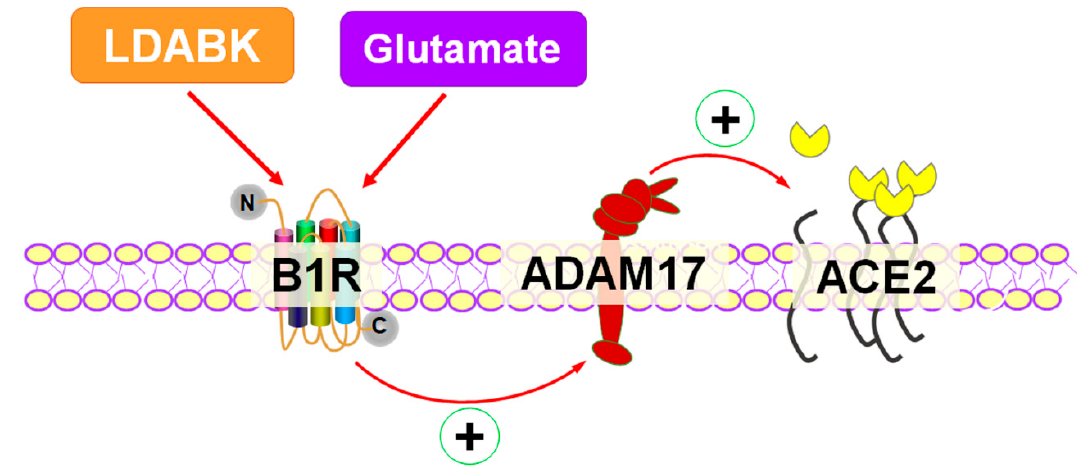
Figure 6. Activation of kinin B1R upregulates ADAM17-mediated ACE2 shedding in primary hypothalamic neurons. B1R activation by specific agonist results in upregulation of ADAM17 expression and activity which results in increased membrane-bound ACE2 shedding and reduced ACE2 activity in primary hypothalamic neurons. In addition, glutamate can induce B1R expression and B1R is involved in glutamate-mediated effects on ADAM17 activity and ACE2 shedding.